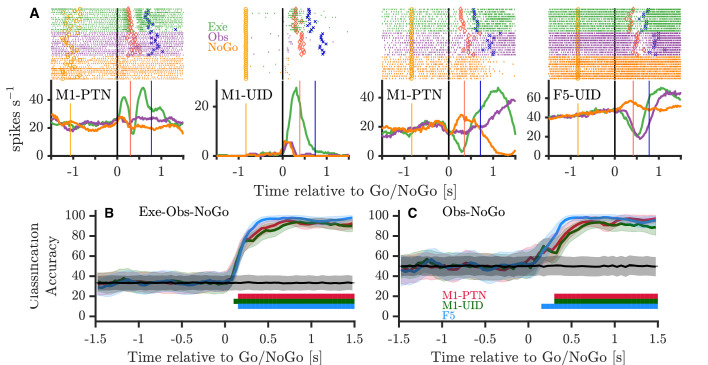
Activity during NoGo.(A) Example single-neuron responses during execution, observation, and NoGo. Each subplot shows a raster and histogram representation of single-neuron activity during PG execution (green), observation (purple), and NoGo (orange), with single alignment to the Go/NoGo cue (vertical black lines). Rasters and histograms are compiled from a randomly selected subset of 10 trials in each condition. For histograms, firing rates were computed in 20 ms bins and boxcar-smoothed with a 200 ms moving average. Event markers colour-coded as shown previously (Figure 1C). (B) Classification accuracy of maximum correlation coefficient classifier decoding between execution, observation, and NoGo conditions within each population. Grey trace and shading shows mean ±1 SD of decoding accuracy following permutation shuffling, and coloured bars along bottom show period of consistent significant decoding for each population. (C) As for (B) but decoding between observation and NoGo only.